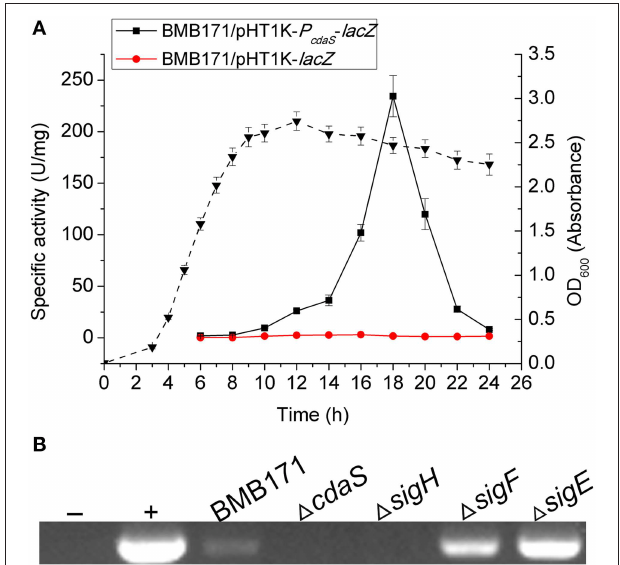
FIGURE 5 | The transcription of cdaS . (A) β -galactosidase activity of BMB171/pHT1K- P cdaS - lacZ . Strains were cultured in GYS medium at 28 ◦ C, and BMB171/pHT1K- lacZ was used as the negative control strain. The dashed line represents the growth curve of BMB171/pHT1K- lacZ . Data represent the mean of three independent experiments (error bar: standard error of the mean, SEM). (B) Detection of cdaS transcripts in different strains by RT-PCR. Total RNA was extracted from each sample after 18h of growth in GYS medium. Lane -: H 2 O template; lane +: BMB171 genomic DNA template.